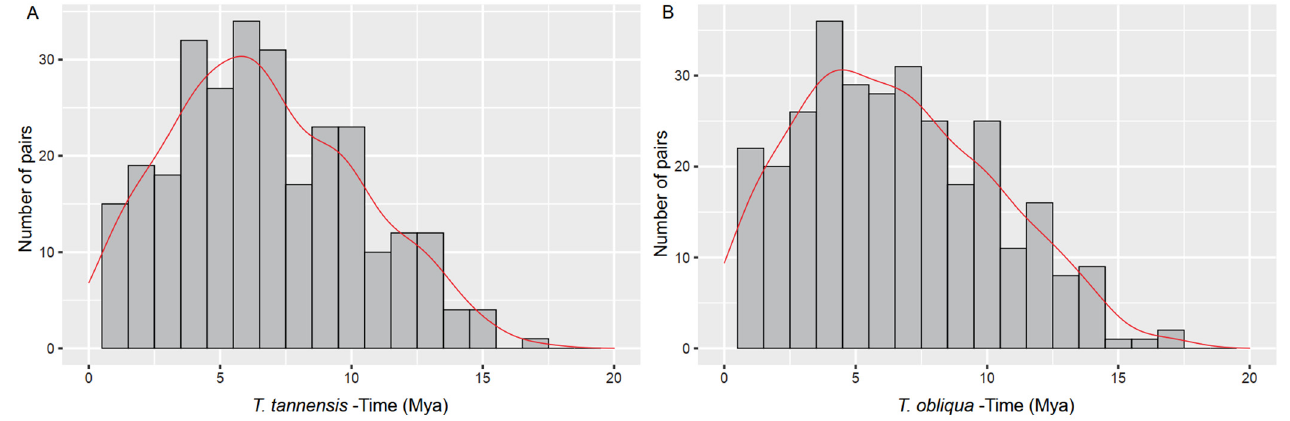
Figure 4. Average insertion times of LTRs of transposable elements in Tmesipteris : ( A ) T. tannensis and ( B ) T. obliqua .